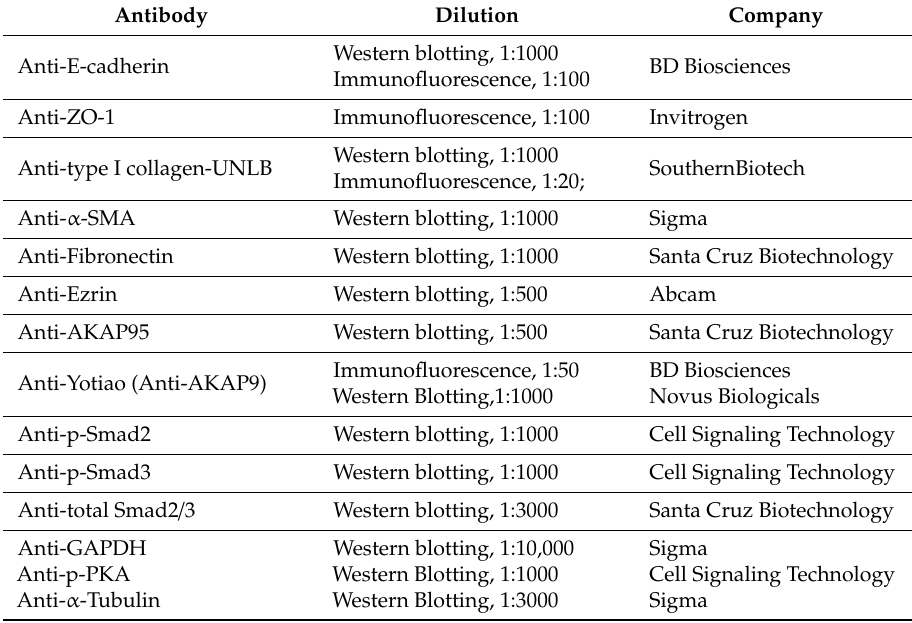
Table 1. Antibodies used in western blotting and